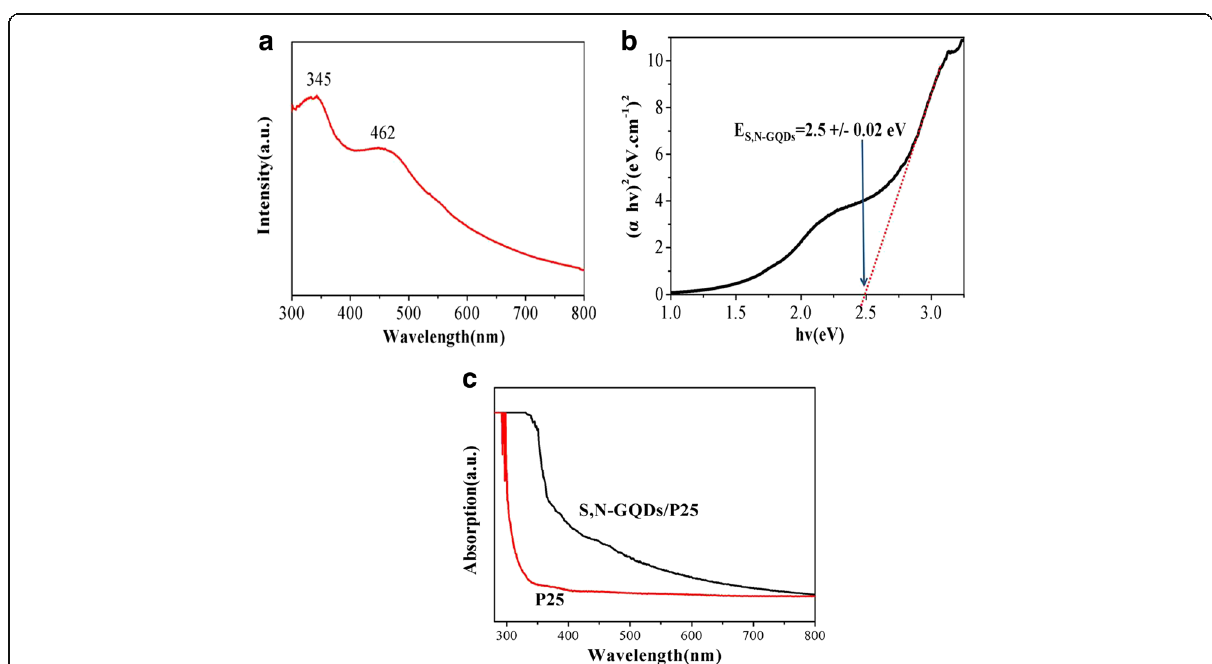
Fig. 5 UV-vis measurements. a The UV-vis absorption spectrum of the S,N-GQDs. b The corresponding Tauc plot of the S,N-GQDs. c The UV-vis absorption spectra of the P25 and S,N-GQD/P25